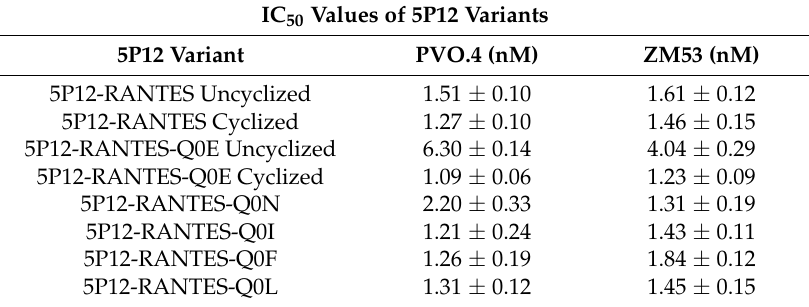
Table 1. IC 50 values of 5P12-RANTES variants (in nM) against a Clade B HIV viral strain (PVO.4) or Clade C viral strain (ZM53) in single-round pseudoviral infection assays. Assays were performed in triplicate and repeated three